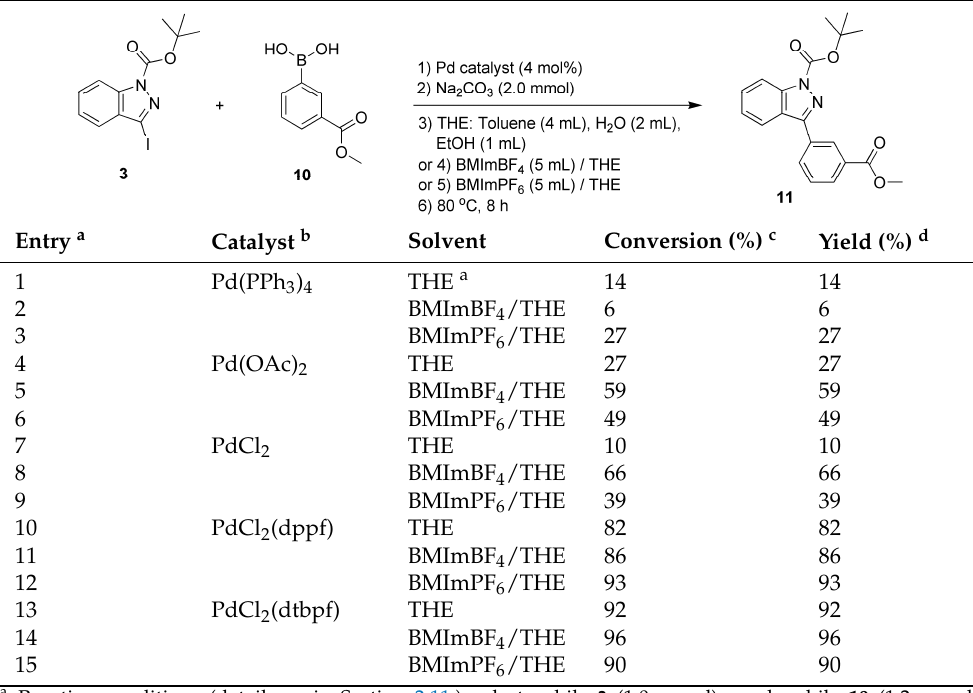
Table 3. Catalytic Suzuki–Miyaura cross-coupling of compounds 3 with 10 .